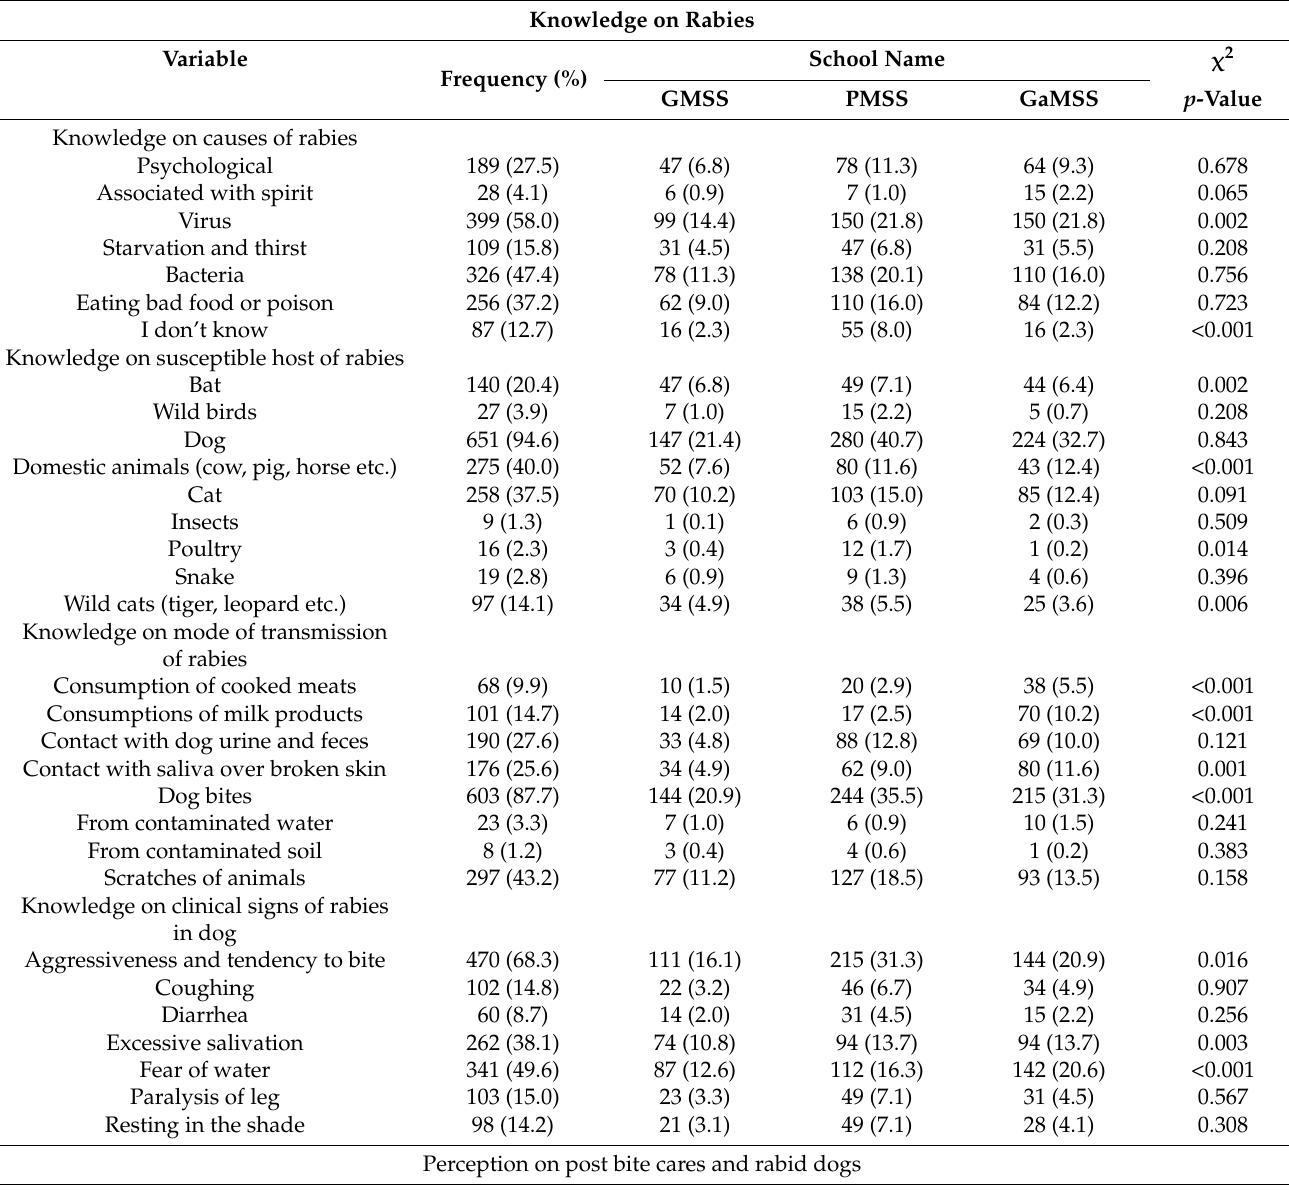
Table 4. Student level of knowledge regarding rabies and perception towards dog bite management and rabid